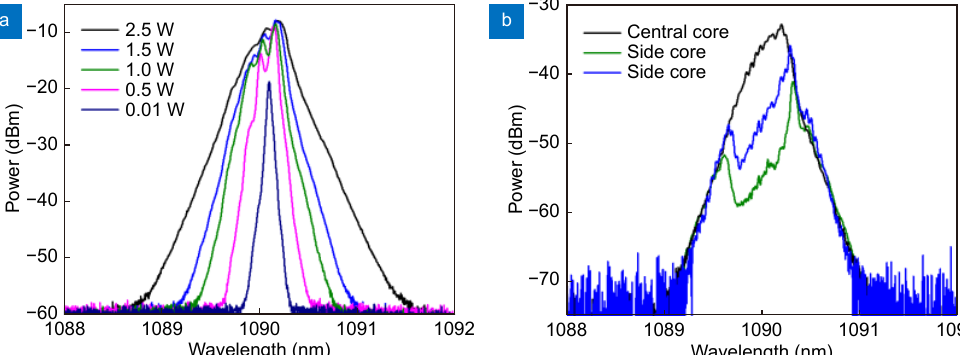
Fig. 14 | ( а ) Backward Stokes wave spectra of the central core. ( b ) Forward Stokes wave spectra of the central and two side cores at the maxim- um input pump